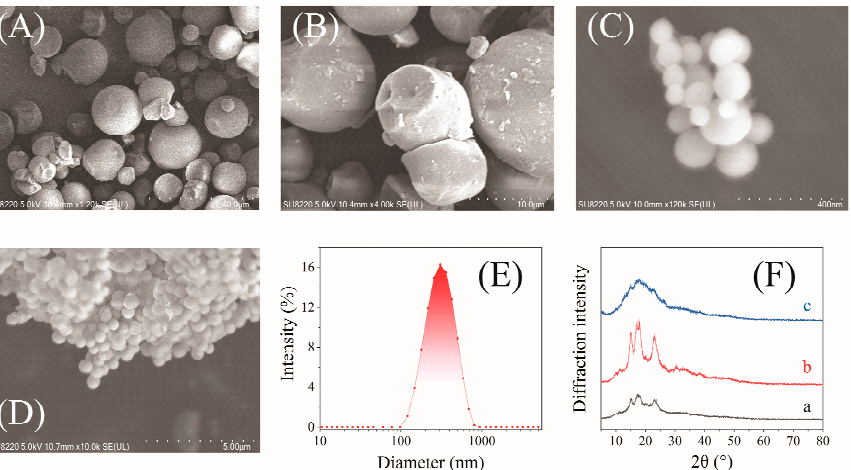
Figure 3. SEM images of ( A ) native cassava starch; ( B ) acid ‐ treated cassava starch; ( C ) CA ‐ CSNPs (×120,000); ( D ) CA ‐ CSNPs (×10.000); and ( E ) the particle size and distribution of CA ‐ CSNPs and the XRD patterns ( F ) of (a) native cassava starch; (b) acid ‐ treated cassava starch; and (c) CA ‐ CSNPs. (The conditions for the preparation of the CA ‐ CSNPs were as follows: a crosslinking agent amount of 15 wt %, an aqueous starch concentration of 6.0 wt %, an oil–water ratio of 10:1 ( v/v ), a total surfactant amount of 0.20 g ∙ mL − 1 , and a CHPTAC amount of 4.05 wt %).